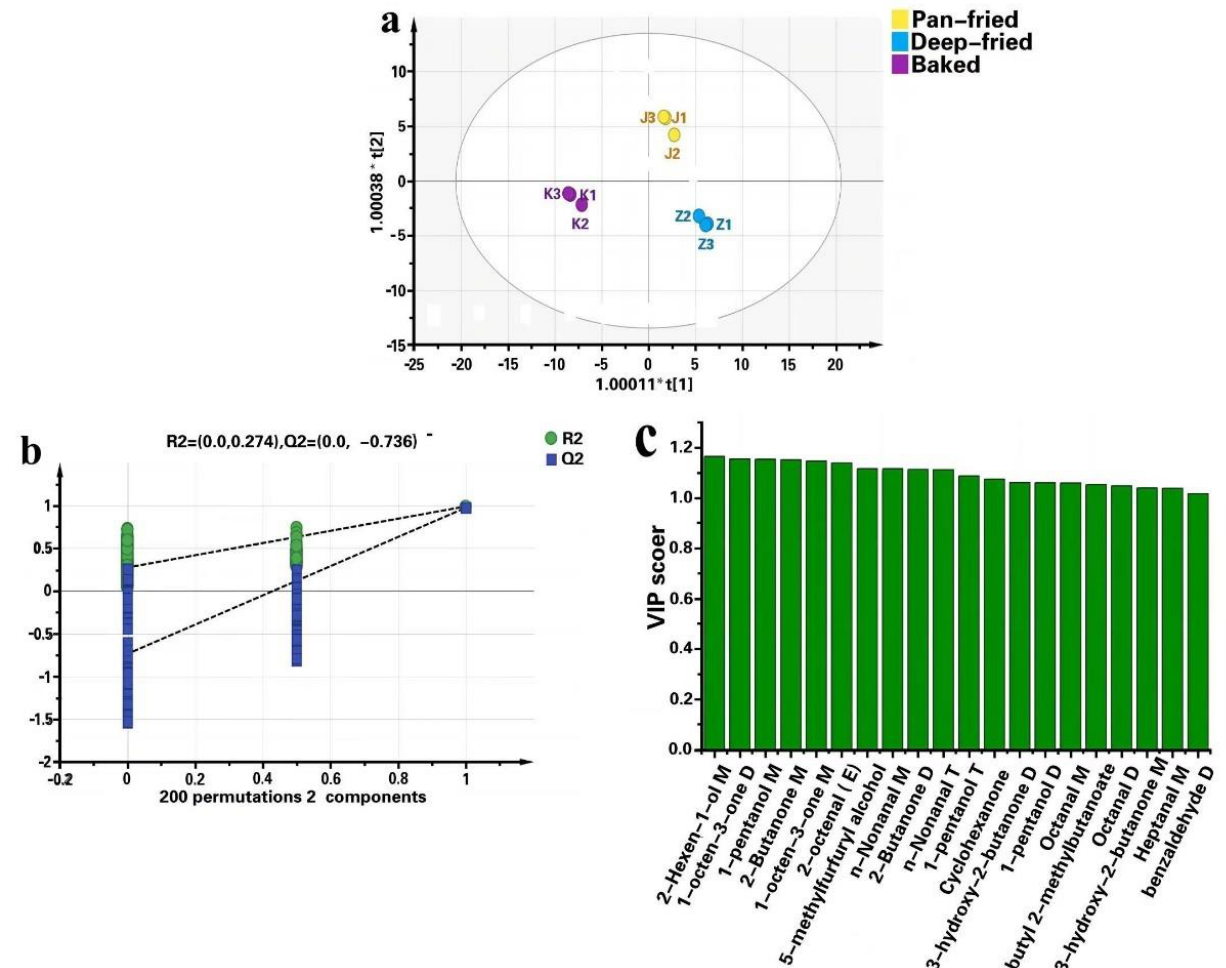
Figure 8. OPLS-DA score plot of volatile flavor compounds in pan-fried, deep- fried and baked BTS meat. ( a ): score plot; ( b ): permutation test plot; ( c ): VIP(variable importance for predictive components) values of volatile flavor compounds in pan-fried, deep- fried and baked BTS meat.